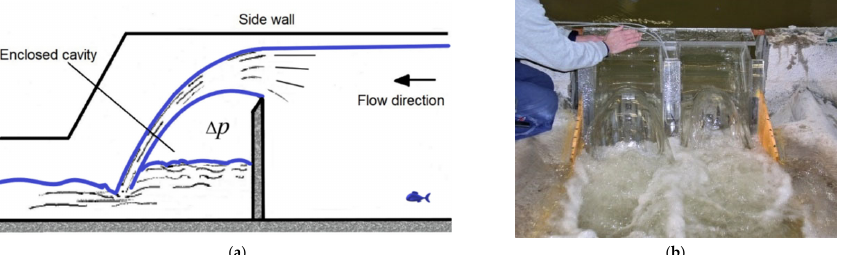
Figure 5. Two examples of formation of enclosed air cavity subjected to sub-atmospheric pressure. ( a ) Air pocket behind a horizontal sharp-edged weir bounded by side walls; ( b ) air cavity surrounded by the flow jets over the flip buckets in gated spillway openings [21].